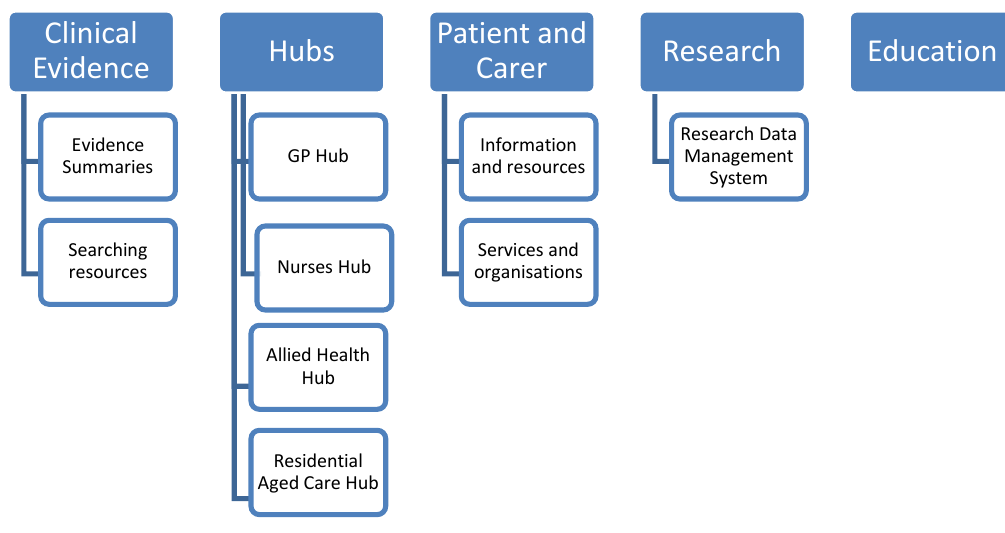
Figure 1. Overview of CareSearch content.